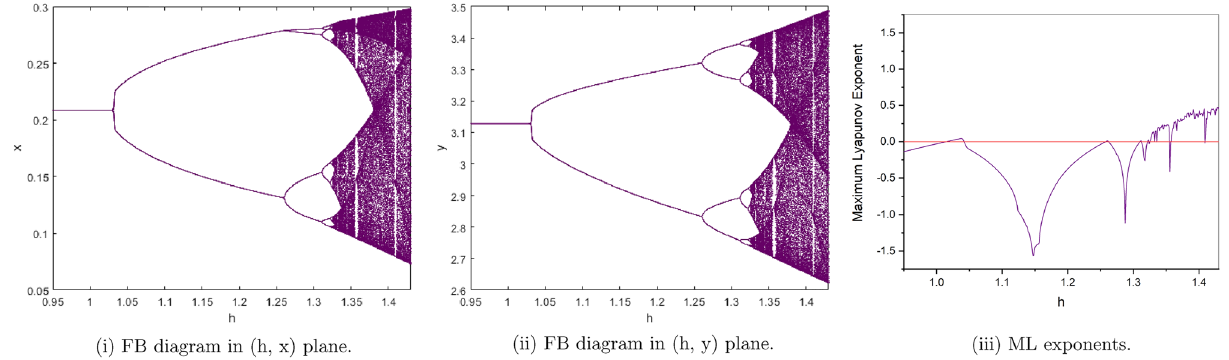
Figure 3. Bifurcation diagrams and ML exponents for the model (i) for values of a = 3, b = 2.5, c = 0.2, e = 0.5, h ϵ [0.95, 1.43].